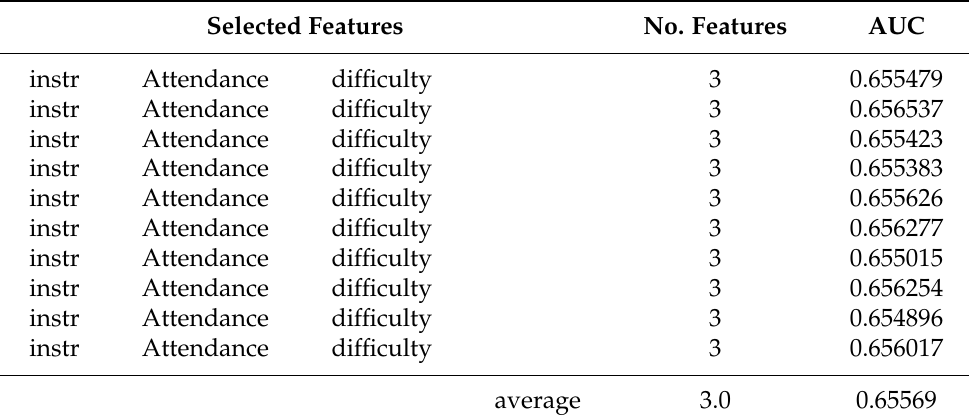
Table 15. The selected features by EWOA-V4 for Data2 over 10 independent runs. Selected